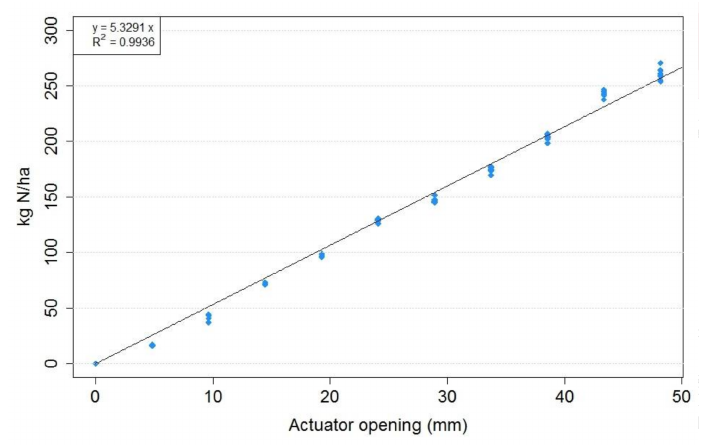
Figure 5. Relationship between amount of fertilizer released by the fluted roller and the actuator opening position.